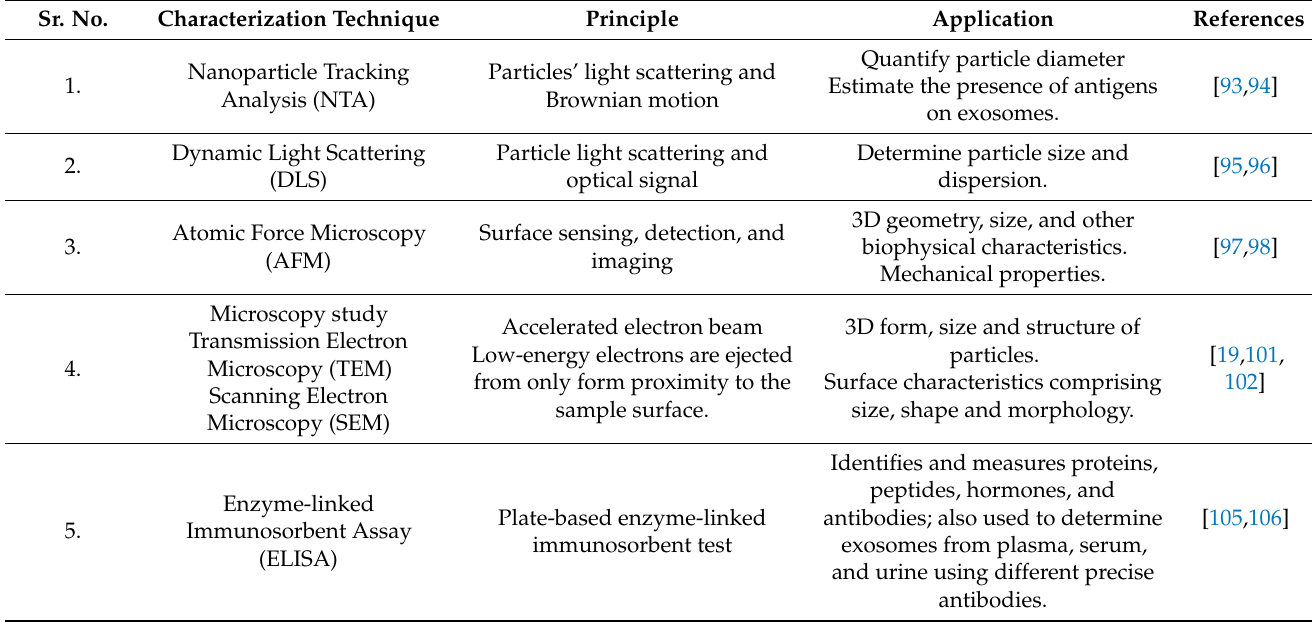
Table 3. Characterization techniques of